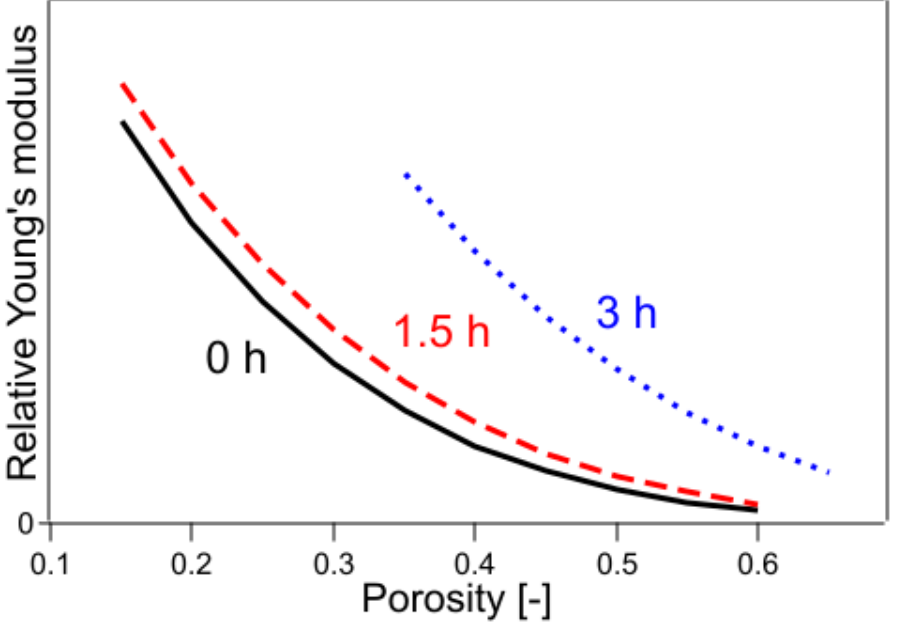
Figure 9. Young’s modulus fitted by Equations (20)–(22). The numbers in the figure indicate the heating time of the